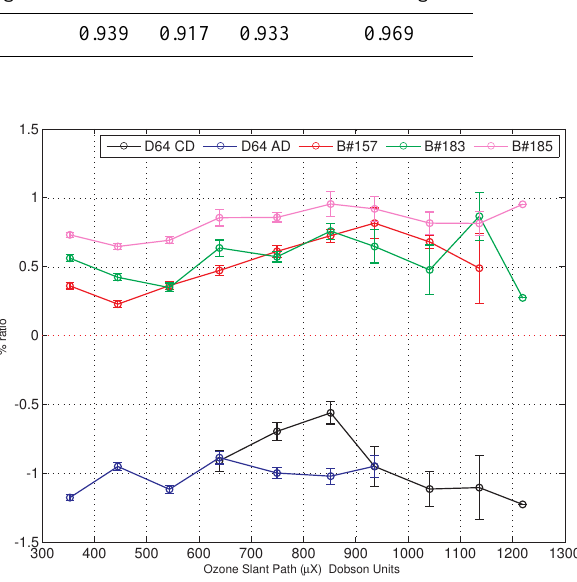
Fig. 7. Brewer–Dobson percentage differences vs. the mean of Eu- ropean reference Brewer (labeled B) and Dobson instruments (la- beled D) taken separately versus ozone slant path ( µ X) during the 2012 Langley plot calibration campaign at Izaña Observatory (IZO). With the exception of the Dobson CD pair at high µ X, there is no evident µ X